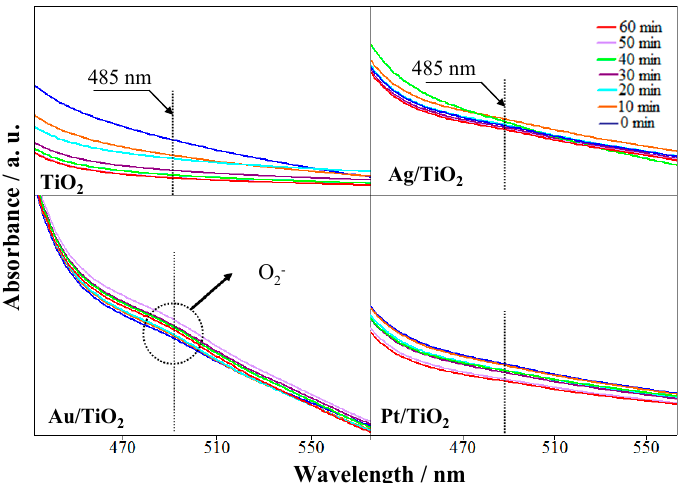
Figure 9. Survey of O 2 − production, by monitoring formazan specific absorbance, over the catalysts exposed to visible light ( λ > 420 nm).